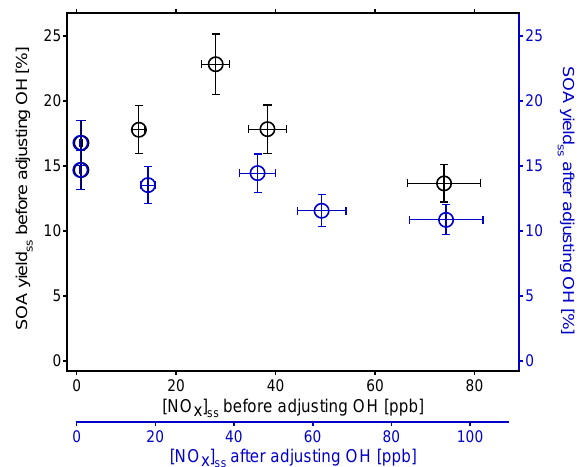
Figure 10. Comparison of SOA yield before (black circles) and af- ter (blue circles) adjusting OH concentration during steady state in NO x experiments performed in the presence of seed aerosol. The er- ror in [NO x ] was estimated to be ± 10% and the error in SOA yield was estimated from error propagation using the sum of the system- atic error, correction procedure error and error in BVOC